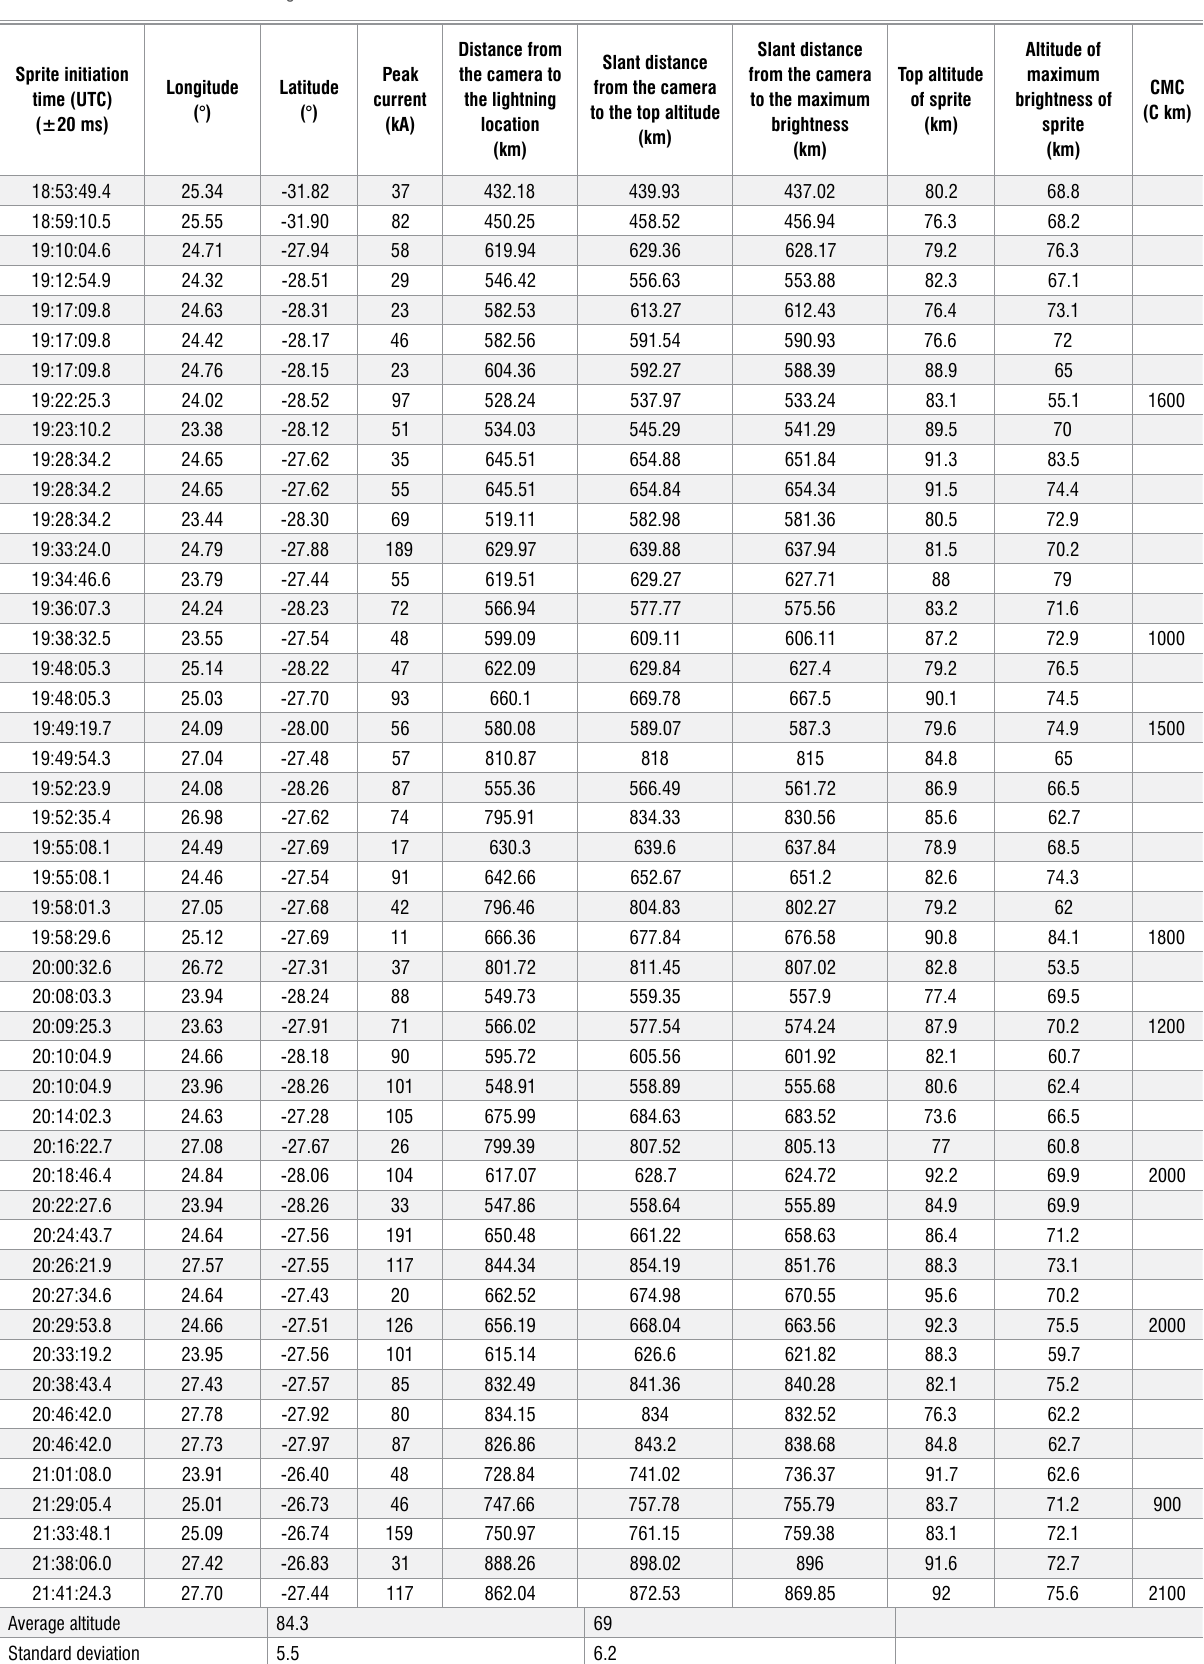
Table 1: Sprite initiation time (coordinated universal time; UTC), lightning location, lightning peak current, distances, sprites’ top altitude and altitude of maximum brightness. Lightning data were provided by the South African Weather Service. The charge moment change (CMC) data were computed from the Schumann resonance station at the Nagycenk Observatory, Hungary (47.62° N, 16.72° E). The sprites’ top altitudes and altitudes of maximum brightness were estimated as described in the text.